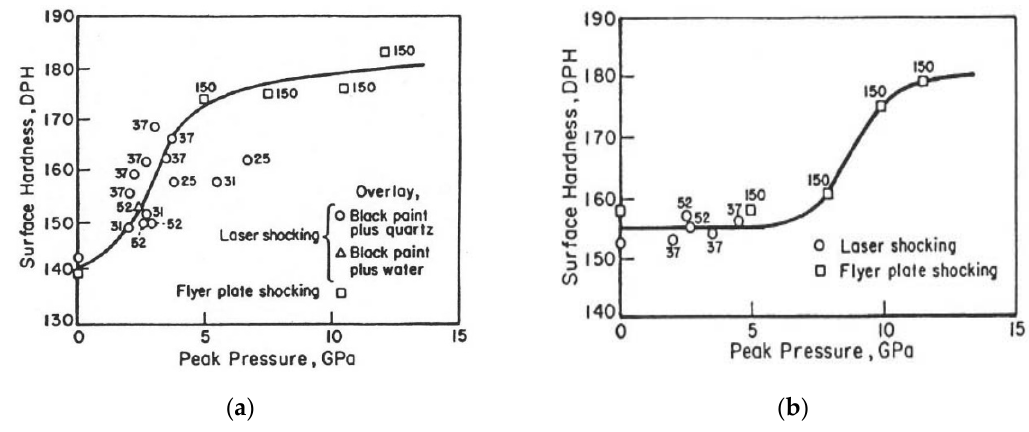
Figure 8. Shock-induced surface hardening dependence on peak pressure. The data point numbers are the pulse width for laser shocks and shock wave width for flyer plate shocks: ( a ) 2024-T351; ( b ) 2024-T851. Reproduced with permission from [26], ASM International, 2019. [27].